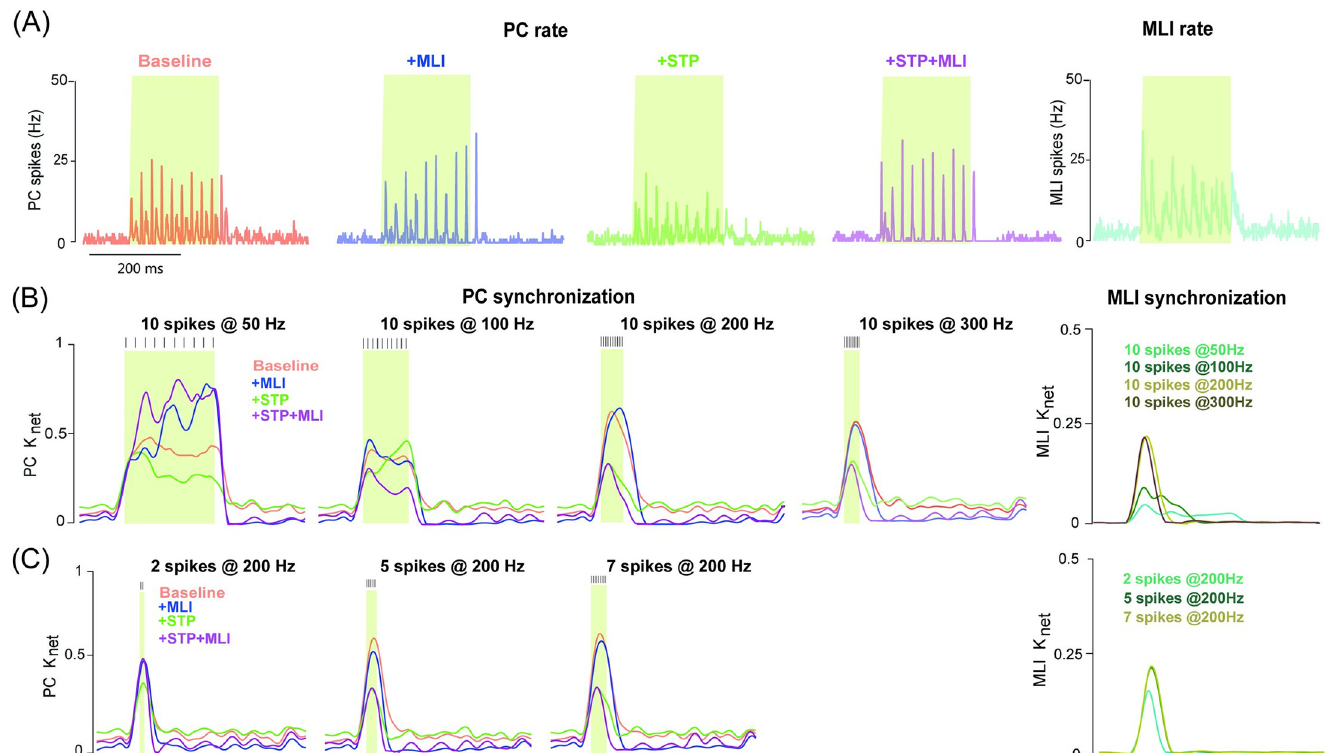
Fig 8. PC synchronization controlled by excitation and inhibition. (A) PC population firing rate in different conditions. (Right) The corresponding MLI population firing rate when MLIs are triggered by GCs. The burst input here is 10 spikes at 50Hz. (B) Time course of PC network synchronization computed from the population PC firing rate, in response to input bursts with 10 spikes at 50, 100, 200 and 300 Hz under different conditions. (Right) The corresponding time course of MLI population synchronization. (C) Similar to (B) but for burst inputs at 200 Hz with 2, 5 and 7 spikes, respectively. Colored shadows indicate burst duration. The background noise are Poisson spikes at 20Hz. The time scale bar in (A) applied in all the plots.